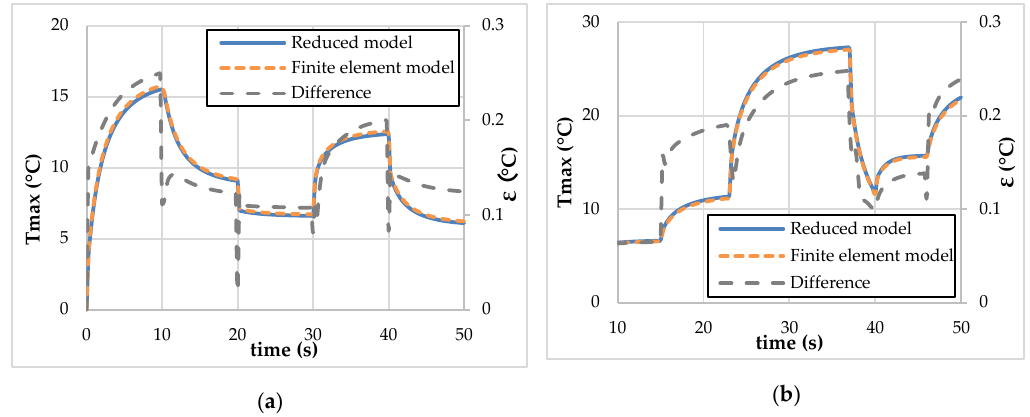
Figure 12 : Temporal evolution of the maximum temperature reached by the ball-grid-array (BGA)– difference on this parameter between the reduced and the finite element model for test case 1 ( a ) and 2 ( b ).